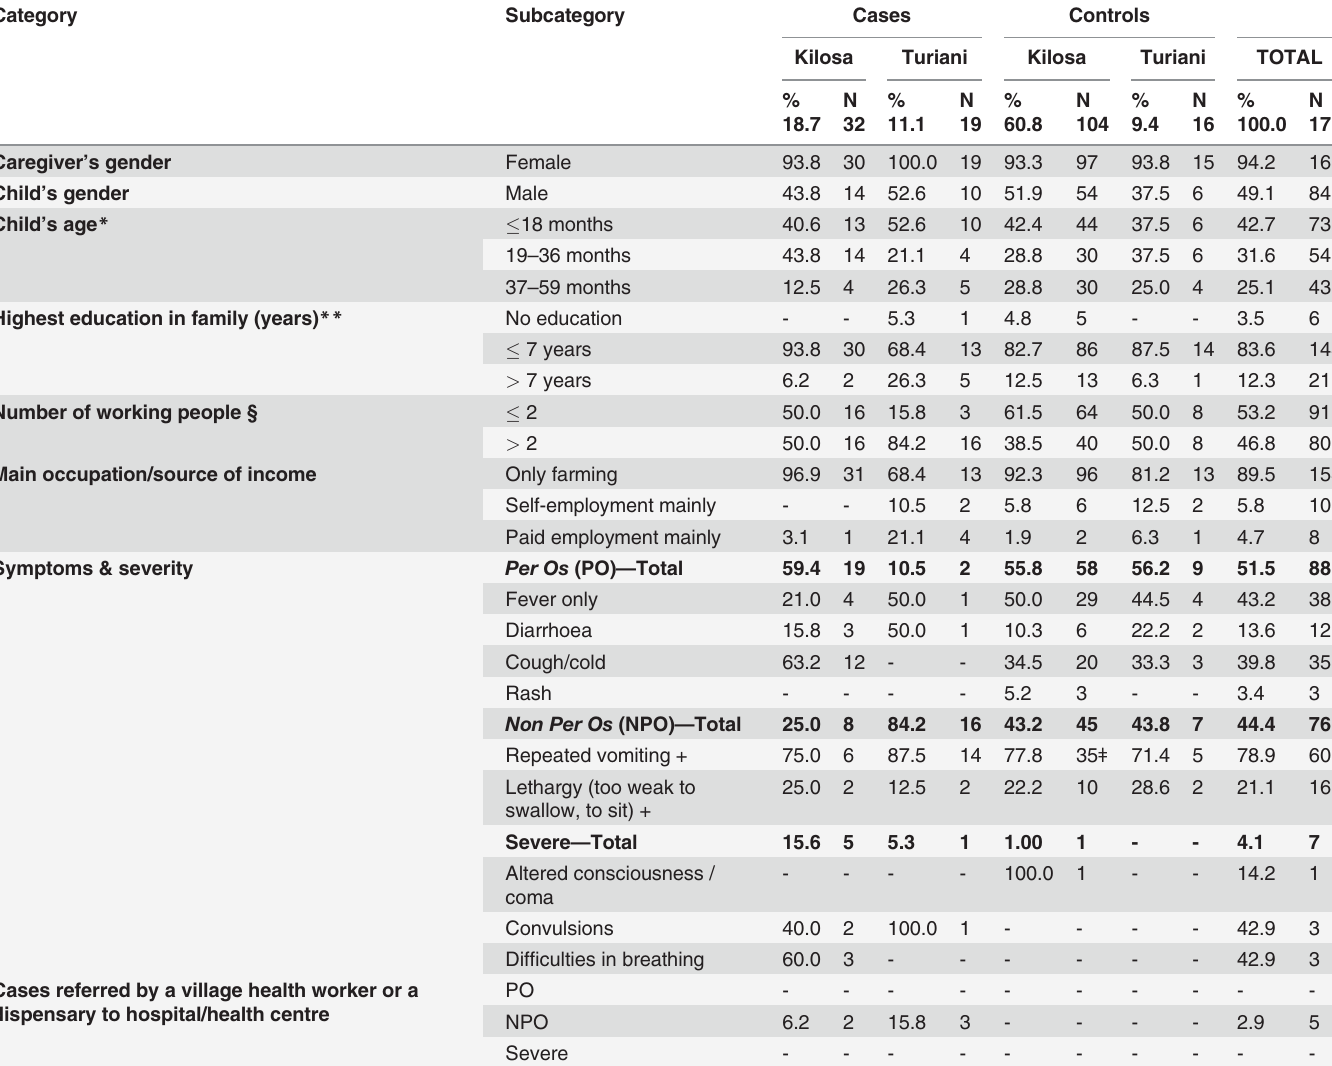
Table 1. Baseline characteristics: cases versus controls by